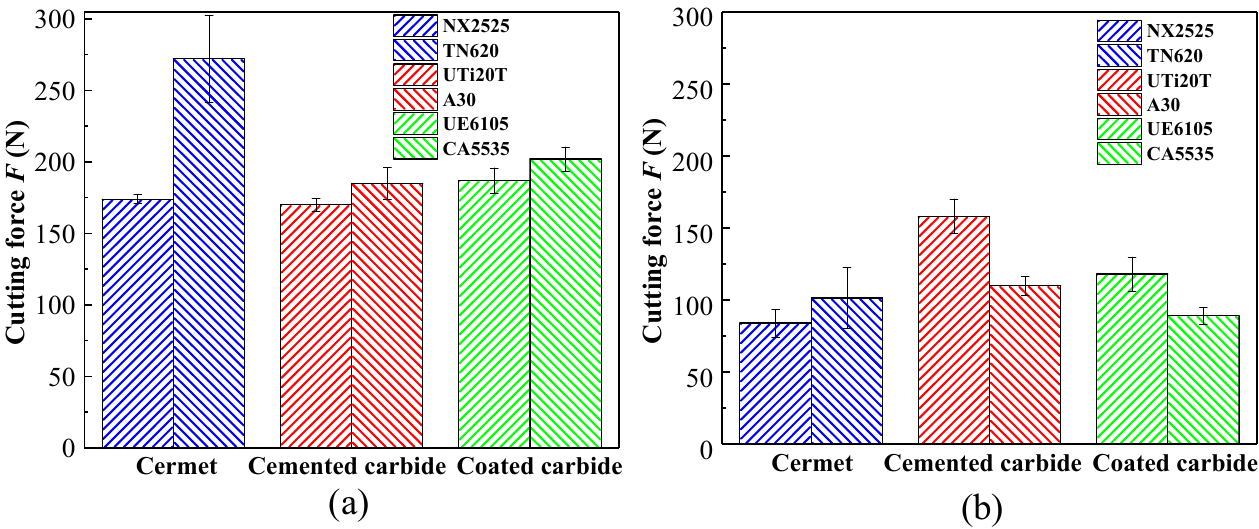
Figure 2. Cutting force for each tool at both cutting speeds: ( a ) 40 m/min and ( b ) 80 m/min.